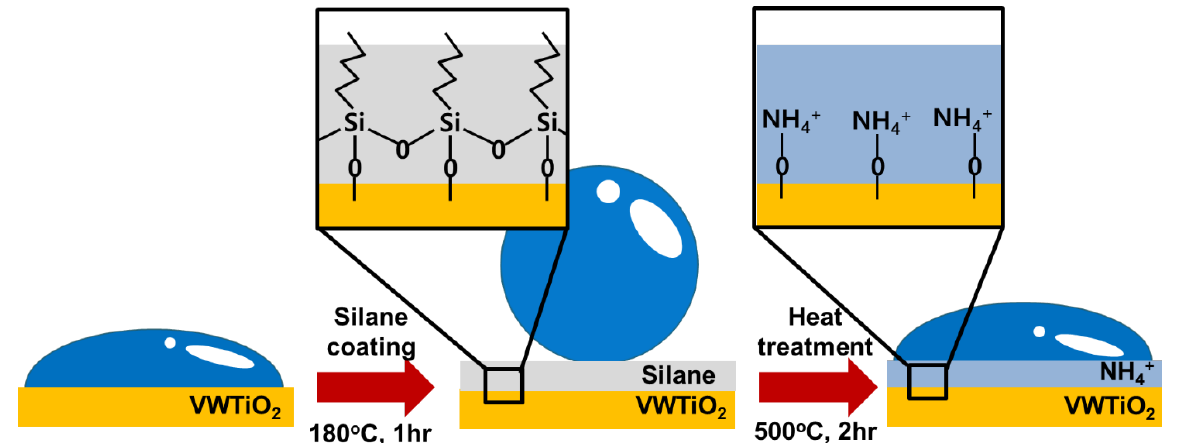
Figure 1. Schematic illustration of V 2 O 5 -WO 3 /TiO 2 , silanized V 2 O 5 -WO 3 /TiO 2 , and heat-treated V 2 O 5 -WO 3 /TiO 2 with NH 4+ layer coating.